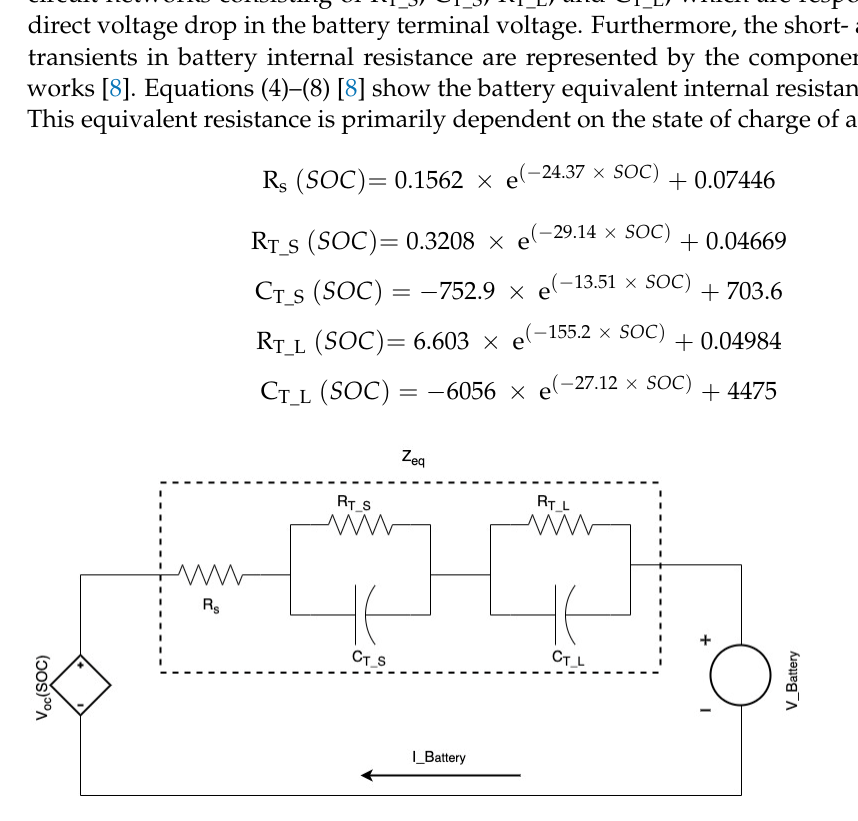
Figure 2. Chen and Mora’s electrical battery model.